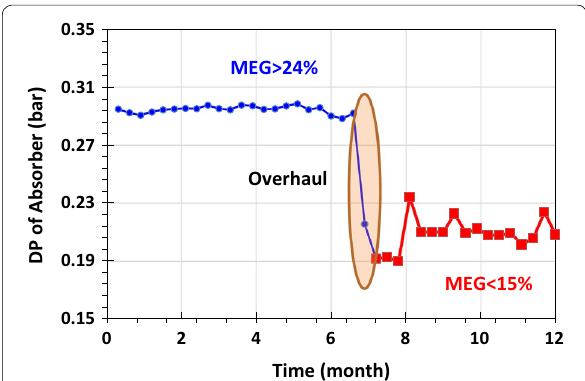
Fig. 12 Differential pressure of amine absorber, overhaul: scheduled shutdown maintenance